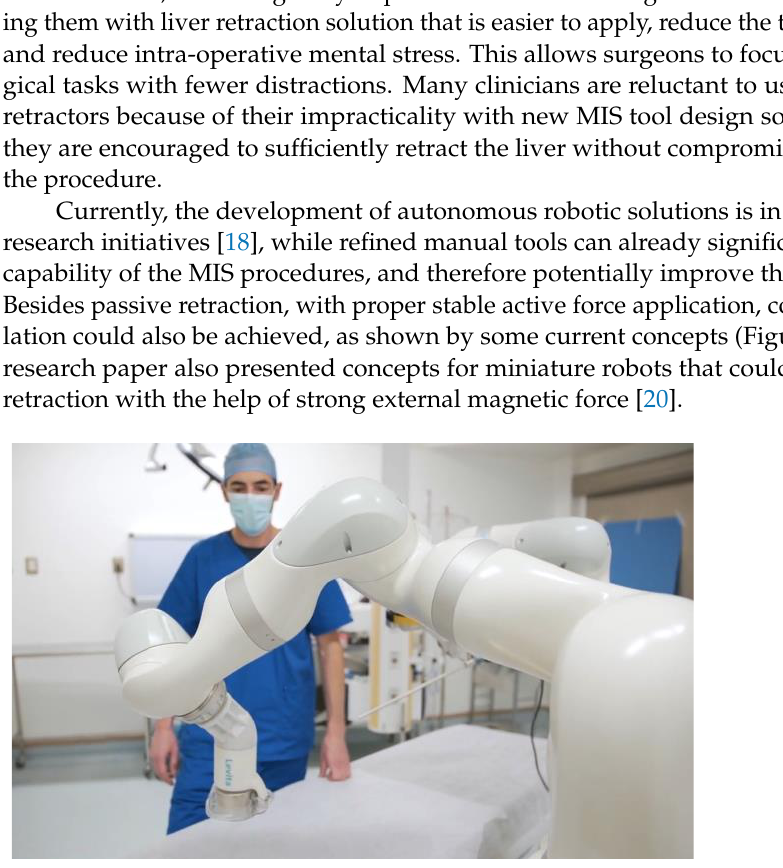
Figure 3. Levita Magnetics’ Robotic Platform (Levita Magnetics Co., Menlo Park, CA, USA) performed the first ever robotic-assisted surgical procedure, a reduced-incision laparoscopic cholecystectomy in July 2021 (Image: Levita Magnetics).